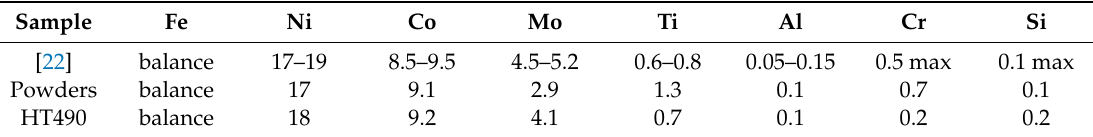
Table 2. Composition of maraging steel samples used to produce test samples in this work. All values in wt%.